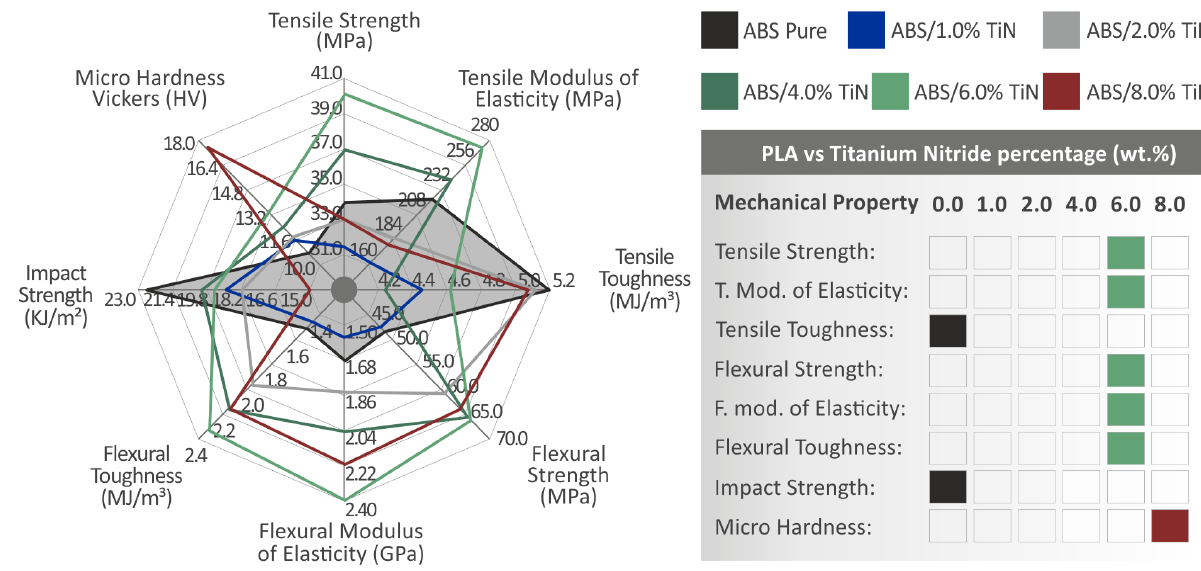
Figure 15. On the left side, the spider diagram depicts all the mechanical properties of the tested 3D-printed specimens. The grey area is representative of the pure ABS material, which was prepared and tested in the study, to be used as the benchmark material for the evaluation of the reinforcement performance. The table on the right presents the materials that exhibit the best mechanical response in each test.